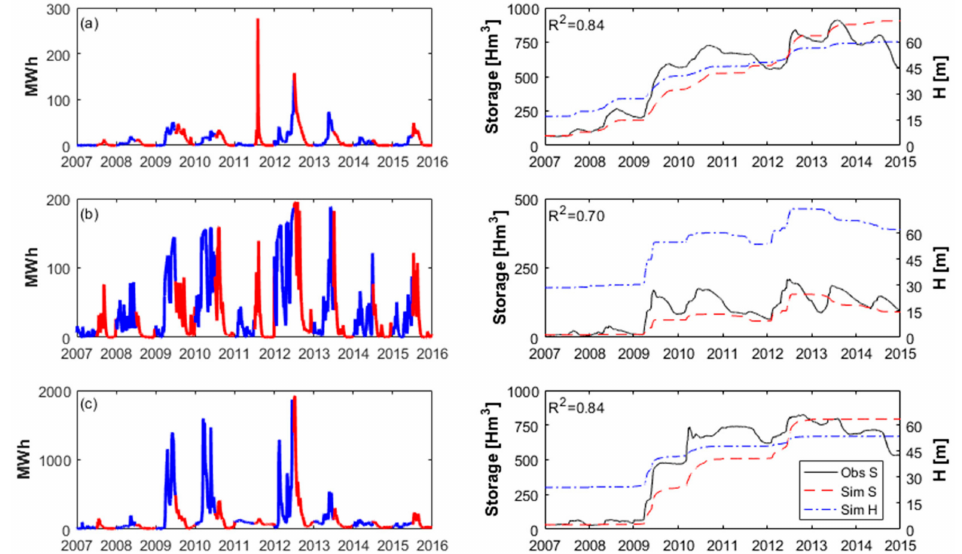
Figure 10. Daily energy generation (left: in blue, winter period October–March; in red, summer period April–September) and comparison between simulated ( Sim S ) and observed storage ( Obs S ) with level fluctuations ( Sim H ) on the right for studied reservoirs: ( a ) Alarcon; ( b ) Fuensanta; ( c ) La